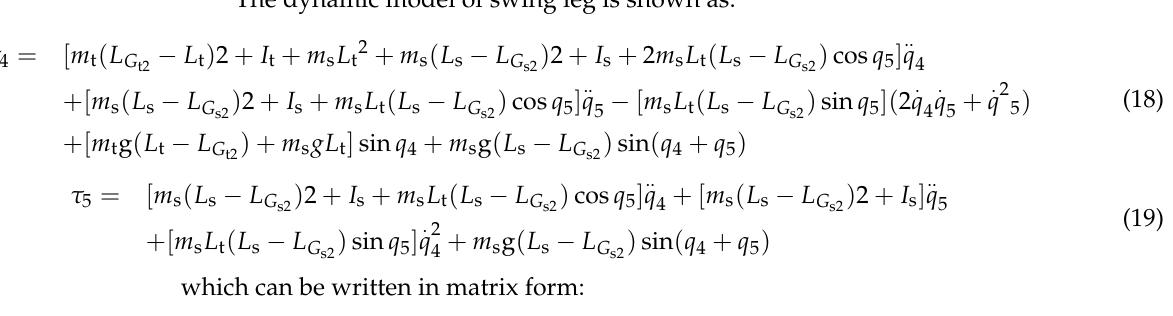
G and G are mass centers of crus. s1 s2